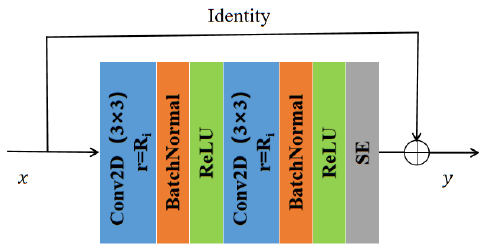
Figure 4. Residual atrous convolution.